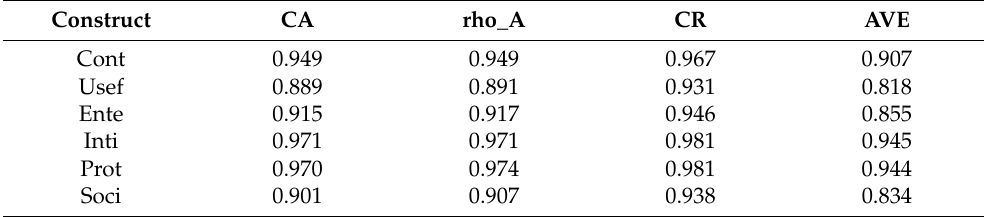
Table 3. Descriptive statistics for the constructs.